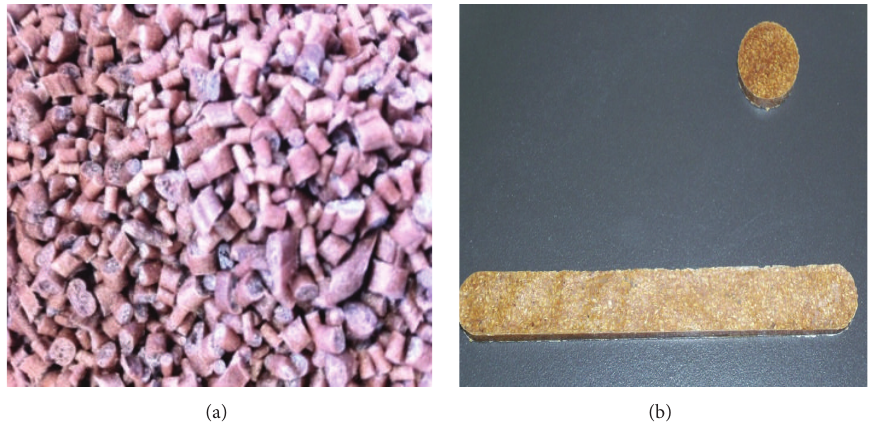
Figure 1: Pellets (a) and compression molded samples (b) of wood polymer composites.